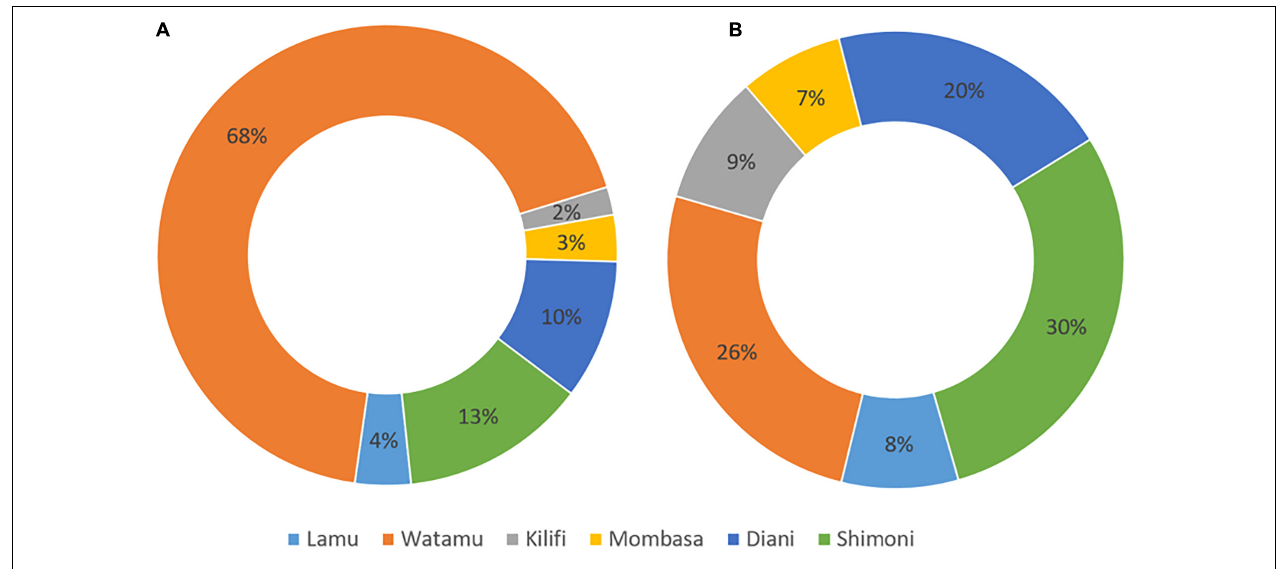
FIGURE 3 | Geographical coverage of the KMMN MU reports: (A) from 2011 to 2017, (B) from 2018 to